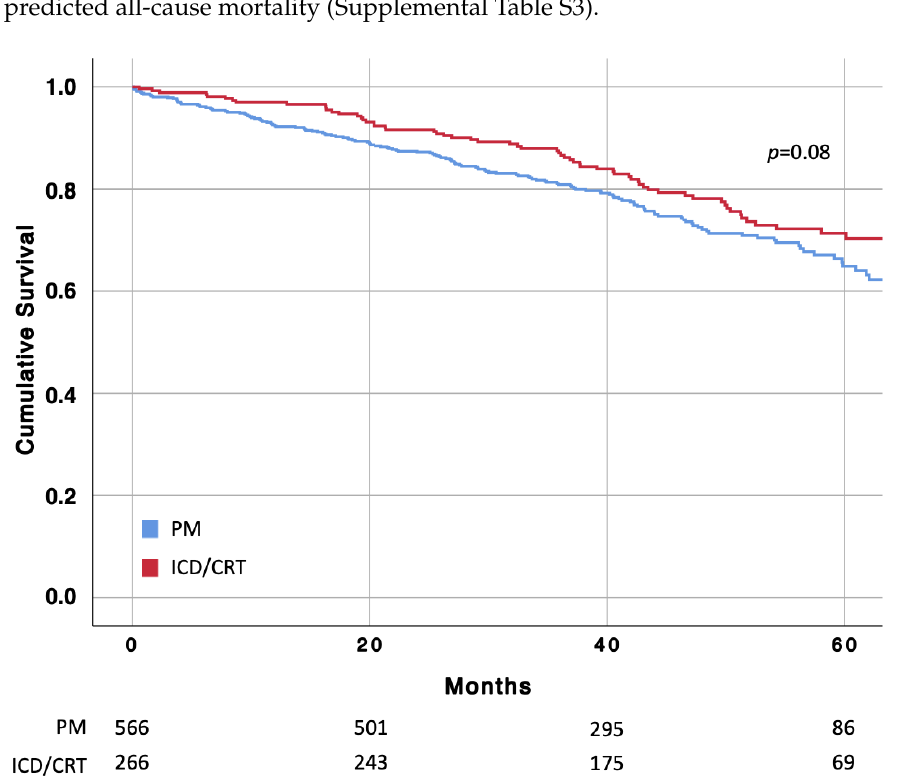
Figure 2. Cumulative incidence of all-cause death in patients with pacemaker (PM) and implantable cardioverter defibrillator (ICD)/cardiac resynchronization therapy (CRT) estimated using the Kaplan–Meier method. Table 3. Univariate and multivariate Cox’s regression analysis for all-cause mortality.